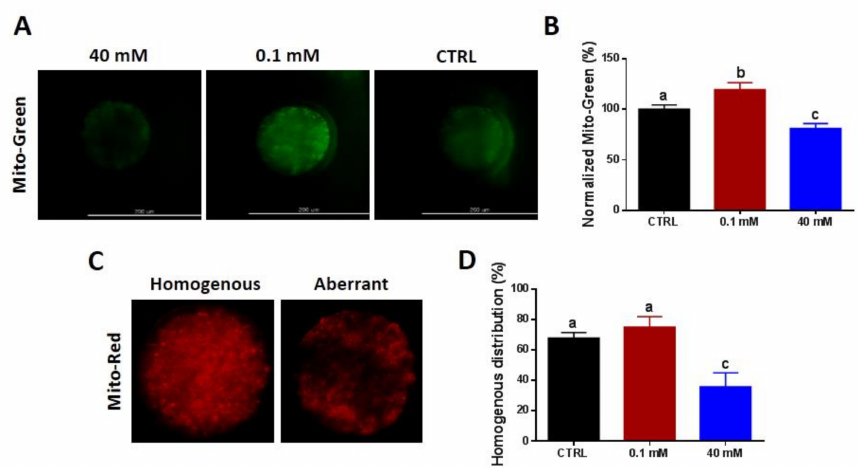
Figure 4. Mitochondrial content and distribution pattern following NAM treatment. Mito Tracker green staining ( A ) and integrated optical density ( B ) of oocyte mitochondrial content. ( C ) Mito Tracker Red staining for mitochondria showing the homogeneous and aberrant distribution patterns. ( D ) Proportion of oocytes with homogeneous mitochondrial distribution. Original magnification 200 × . Mito-Green: Mito Tracker Green; Mito-Red: Mito Tracker Red. Superscripts with different letters indicate statistical